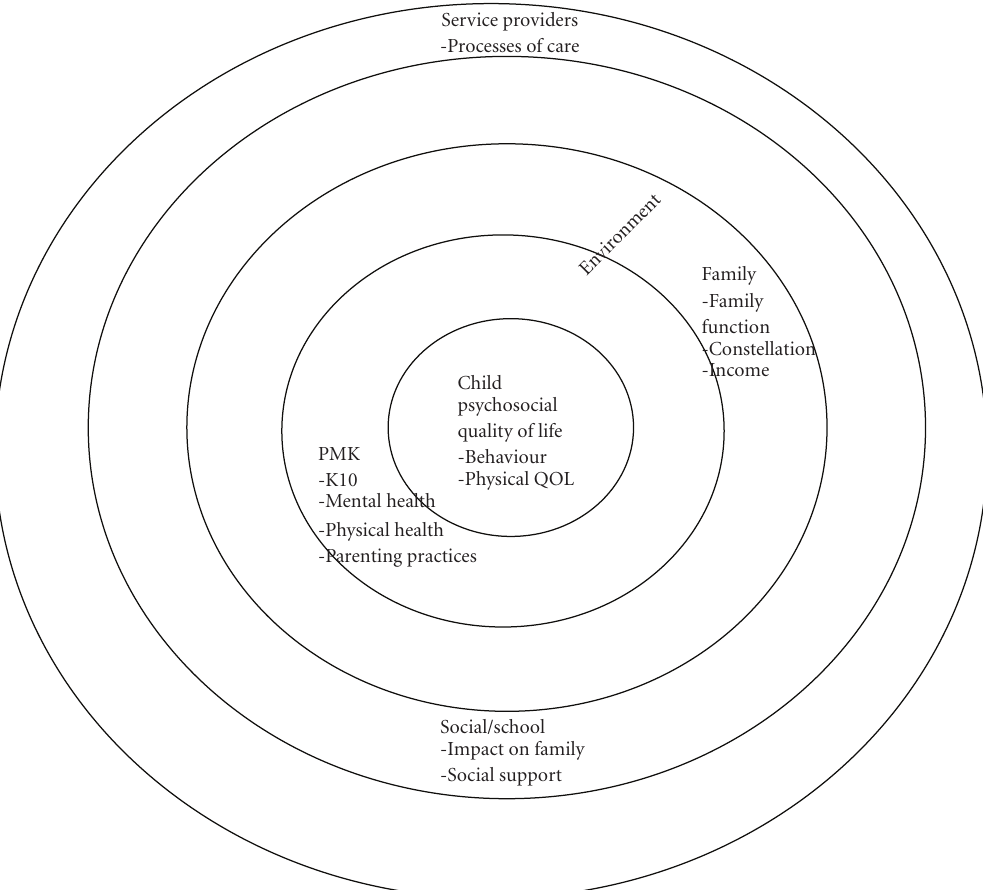
Figure 1: Bioecological model of key factors and their interactions with child psychosocial